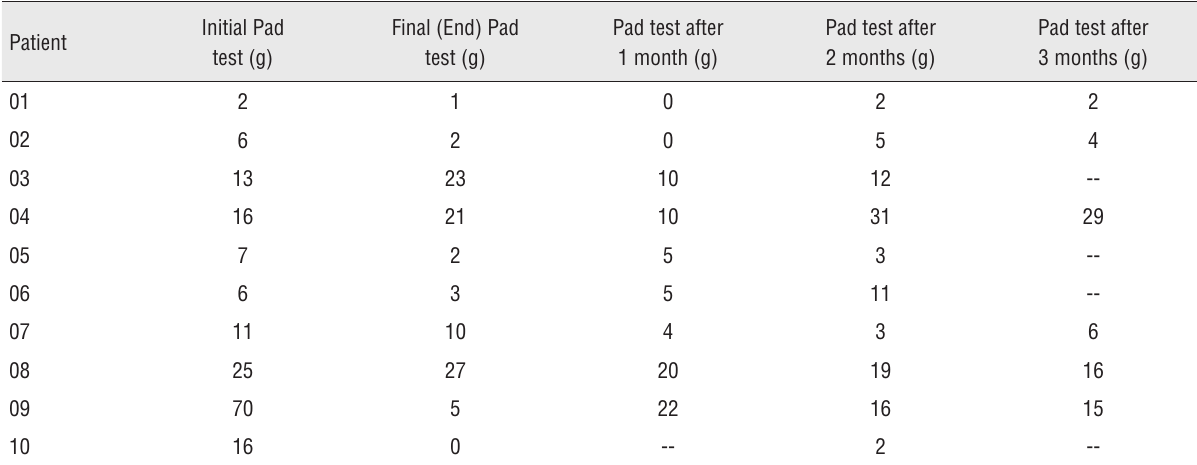
Table 2 - Results of urinary loss in grams (g) of 10 patients who underwent non-ablative radiofrequency treatment on external urethral meatus measured by Pad Test, Bahia,